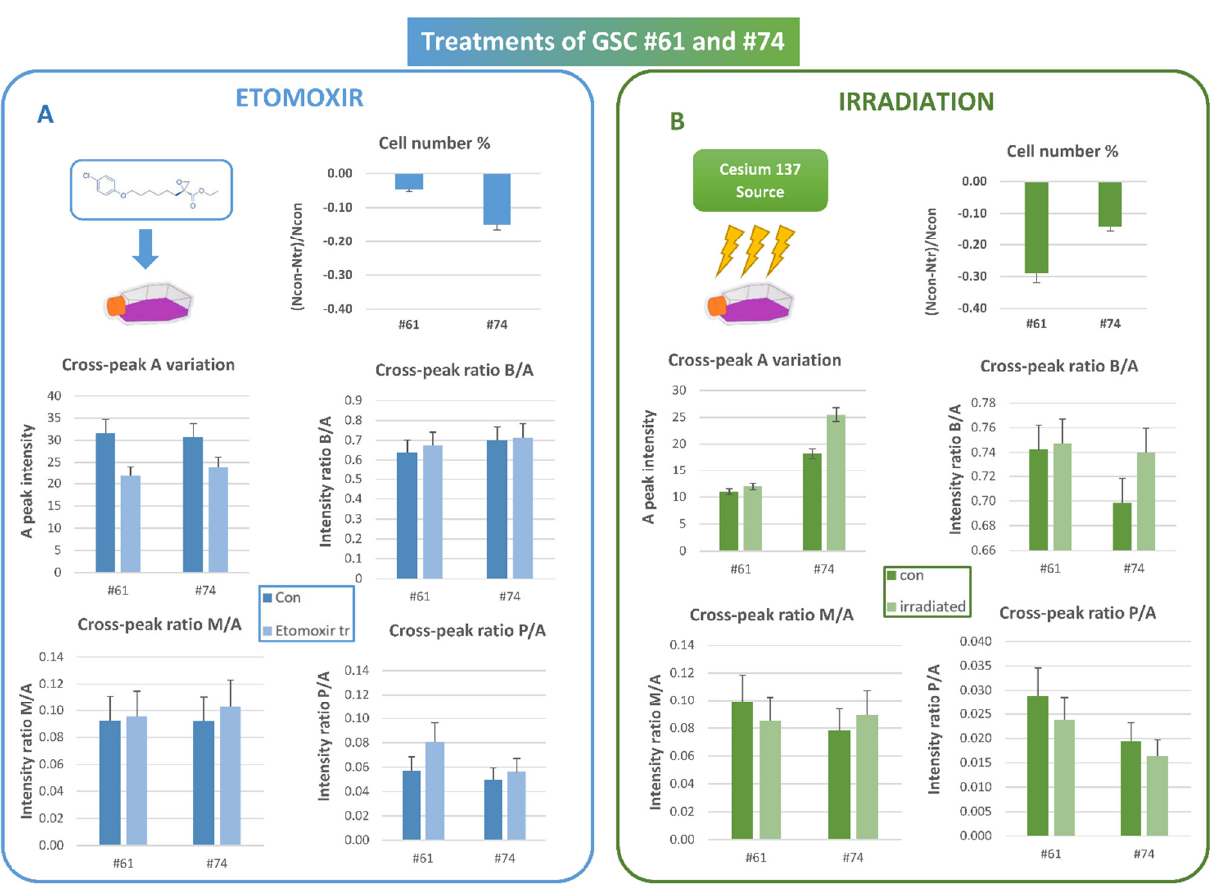
Figure 5. ( A ) Effects of etomoxir treatment on cell number, cross peak A intensity and cross peak B/A, M/A, and P/A ratios measured 24 h after treatment of cell lines #61 and #74. Each point is the average of at least three independent experiments; standard deviations were assigned as error bars. ( B ) Effects of photon irradiation on cell number, cross peak A intensity and cross peak B/A, M/A, and P/A ratios measured 72 h after irradiation of cell lines #61 and #74. Each point is the average of at least three independent experiments; standard deviations were assigned as error bars.